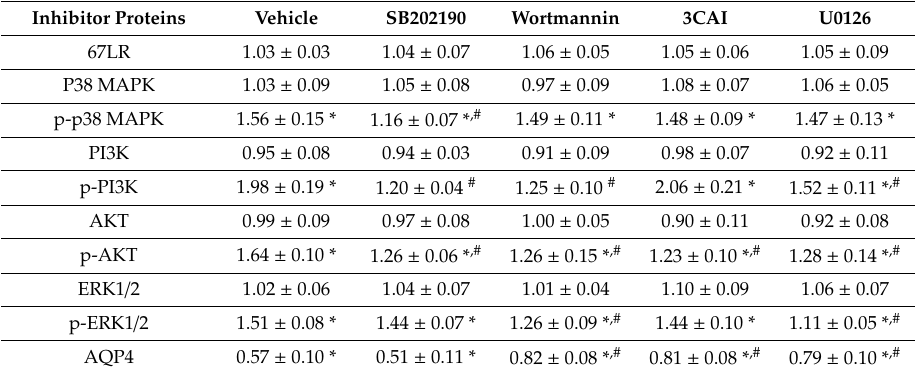
Table 2. Densities (mean ± S.D. fold of control IgG-infused animal level) of 67LR, total kinases, phospho (p)-kinases, and AQP4 in the PC of 67LR IgG-infused animals (* ,# p < 0.05 vs. control IgG and vehicle,